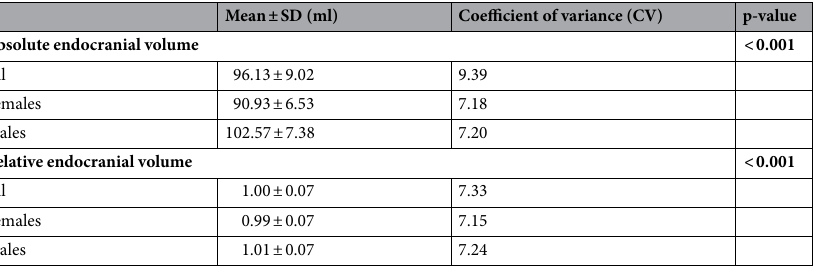
Table 1. Variation and sex differences in absolute endocranial volume and relative endocranial volume (n = 300 females, n = 242 males). Relative endocranial volume is reported as the encephalization quotient (endocranial volume measurements divided by the fitted values of a linear model of geometric mean against endocranial volume). A bolded p-value depicts statistical significance (p < 0.05) calculated by t-tests comparing sexes.